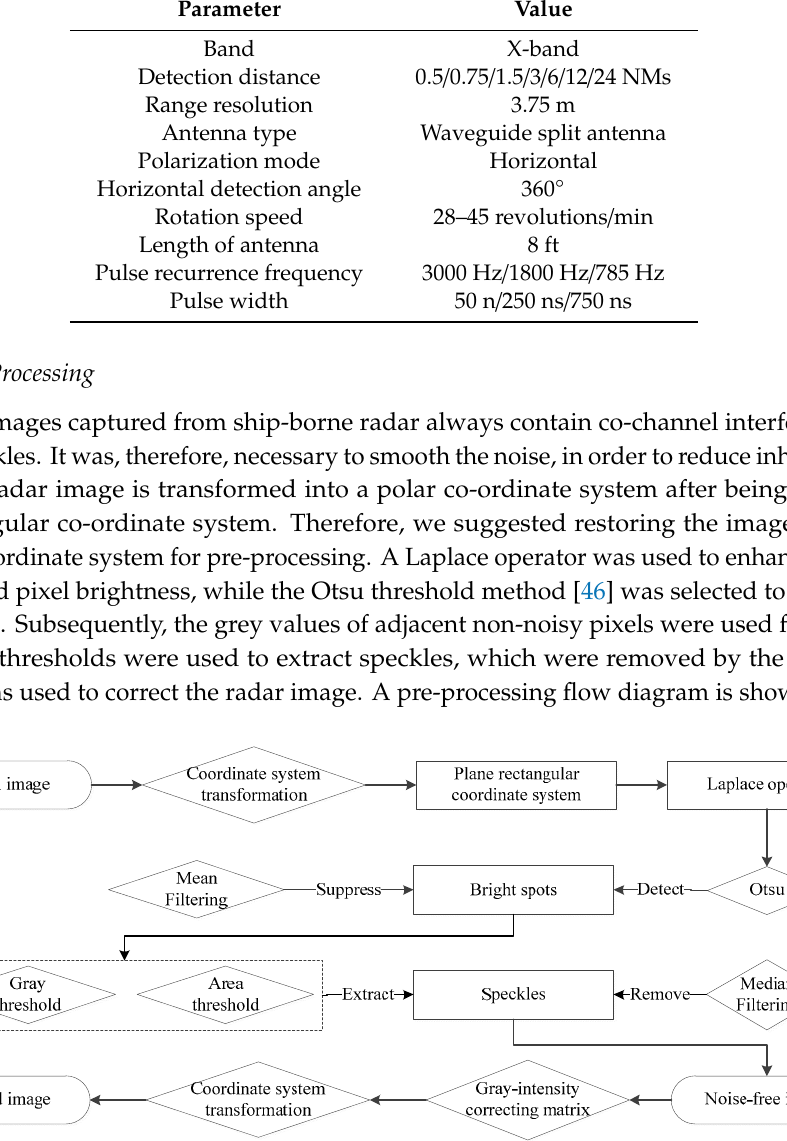
Figure 6. Flow diagram for image pre-processing.